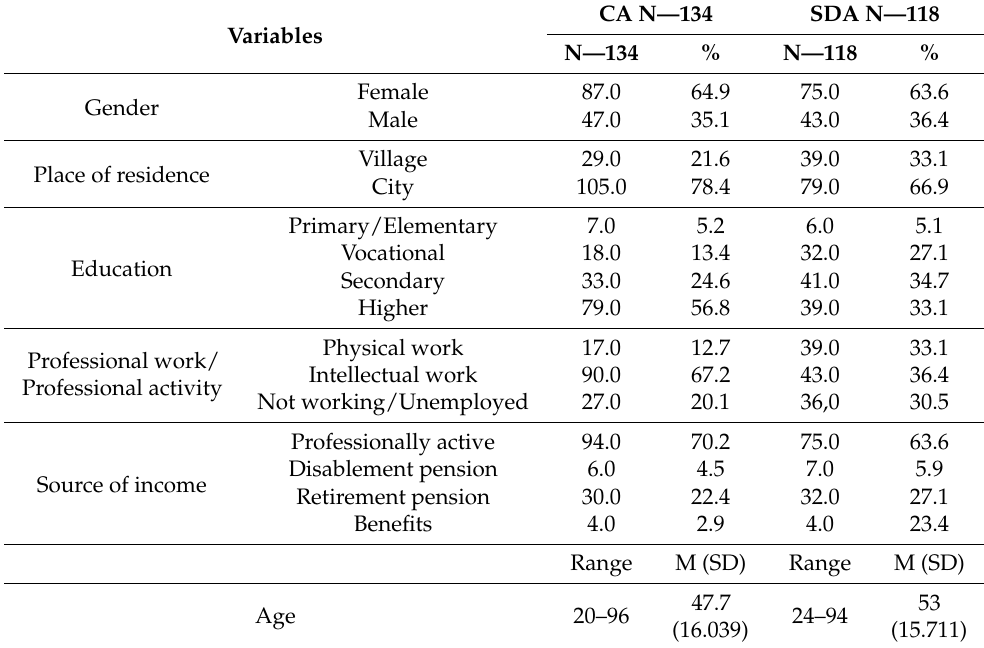
Table 1. Sociodemographic